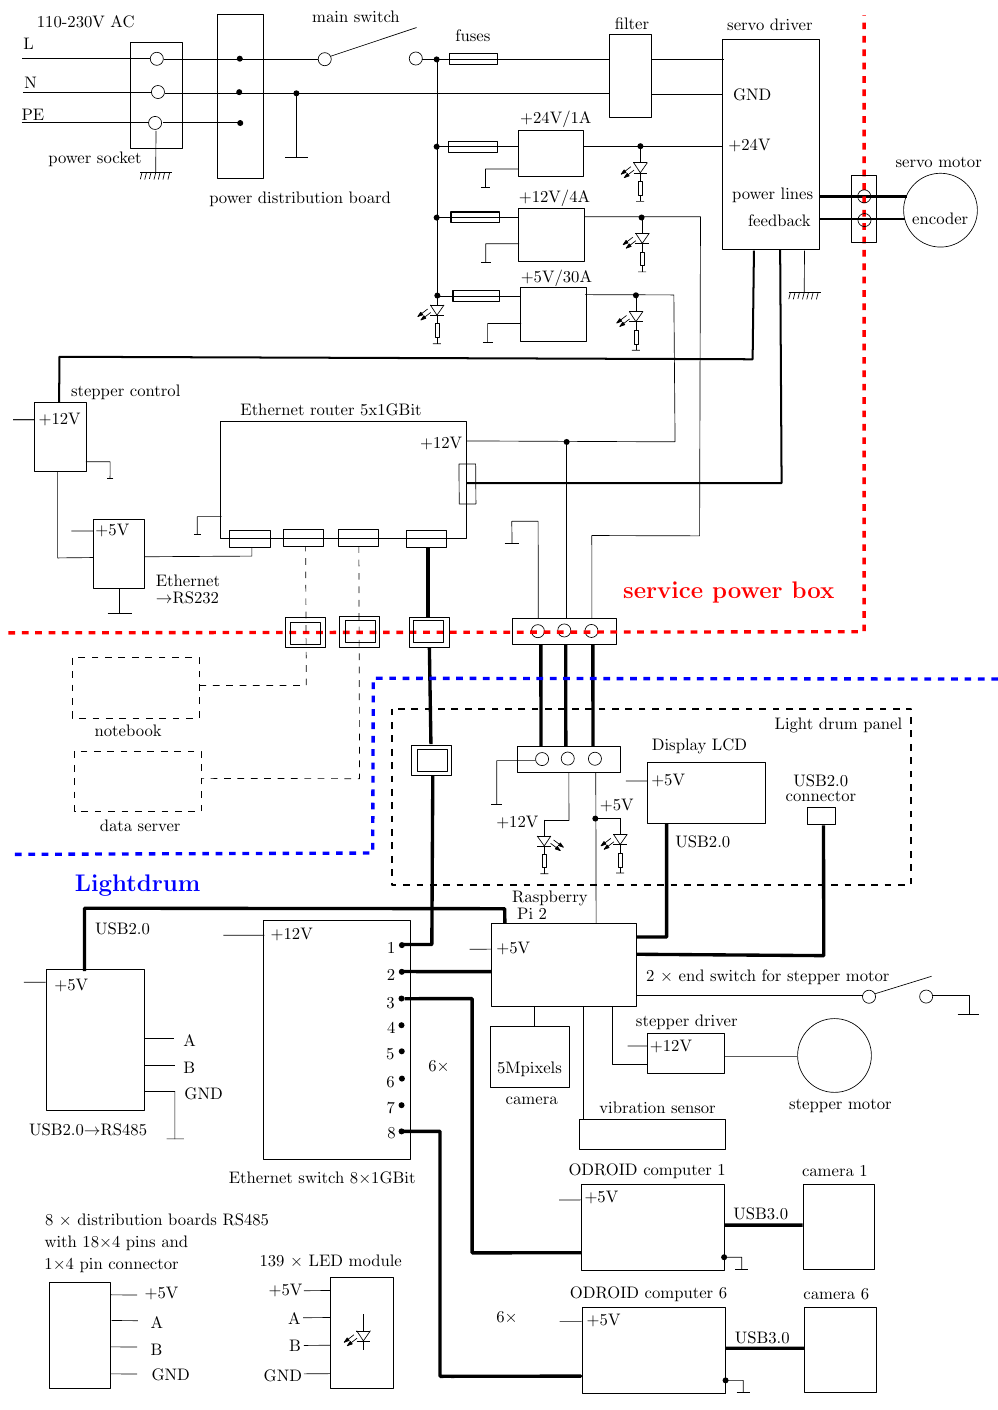
Figure 15. Electronics conceptual scheme for the instrument consisting of three main parts: service power box (separated by red dashed line), lightdrum itself (separated by blue dashed line), and servo motor. The three parts are connected by appropriate cables from service power box: power lines and feedback for servo motor, Ethernet cable and power cable (GND, +5 V, +12 V) to the lightdrum. Optionally, two other devices such as service notebook or data server to operate with the device can be connected via